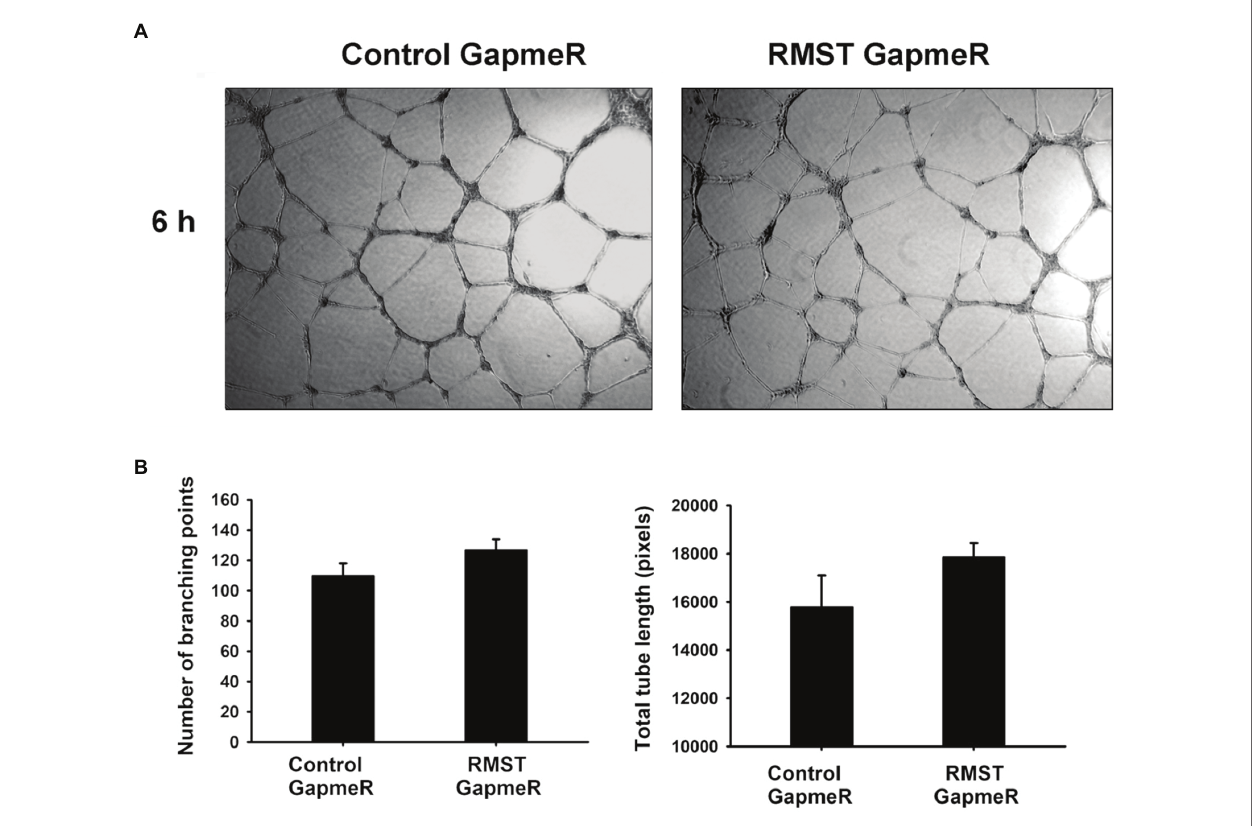
FIGURE 5 | RMST regulation of endothelial cell differentiation. (A) Representative micrographs of control or RMST GapmeR-transfected HUVECs maintained in basic medium for 6 h on growth factor-reduced Matrigel®-coated plates. (B) Number of branching points (left) and total tube length (right) of control or RMST GapmeR-transfected HUVECs maintained in basic medium for 6 h on growth factor-reduced Matrigel®-coated plates. Values are means ± SEM. N =